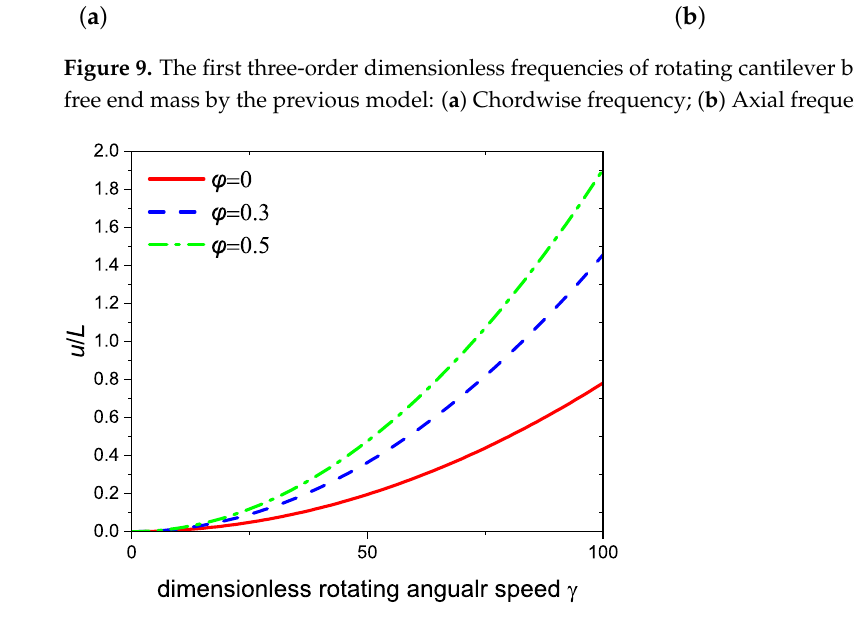
Figure 10. The ratio of free end axial deformation of rotating cantilever beams to beam length with different free end mass ϕ = 0, 0.3, and